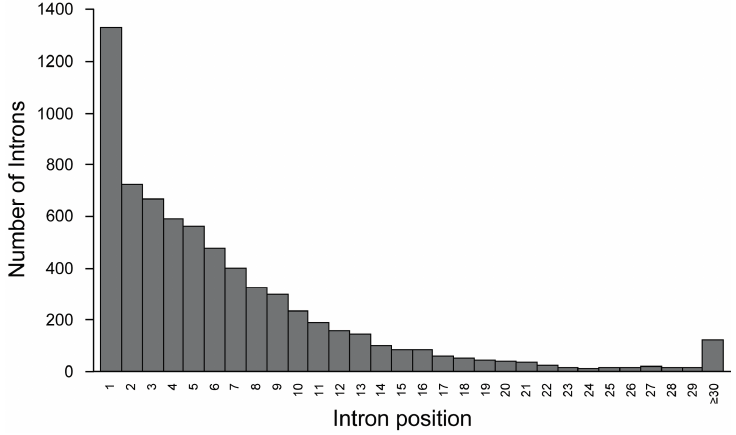
Figure 5. Intron distribution relative to their position in genes. About 20% of all introns subjected to alternative splicing (AS) are intron